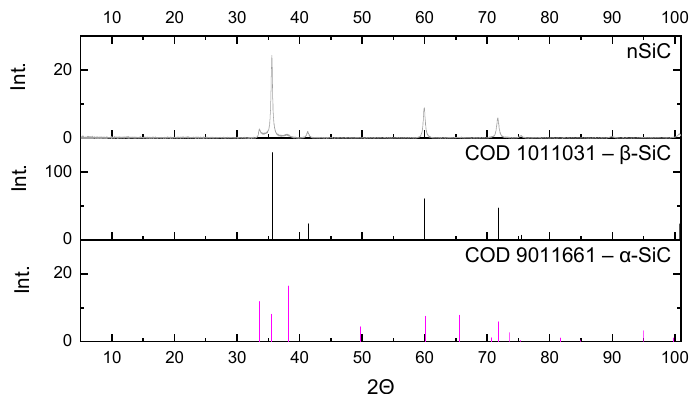
Figure 3. Diffractogram of the silicon carbide nanopowder (nSiC) used in the research and the intensity of the characteristic reflections of phases present in the sample.